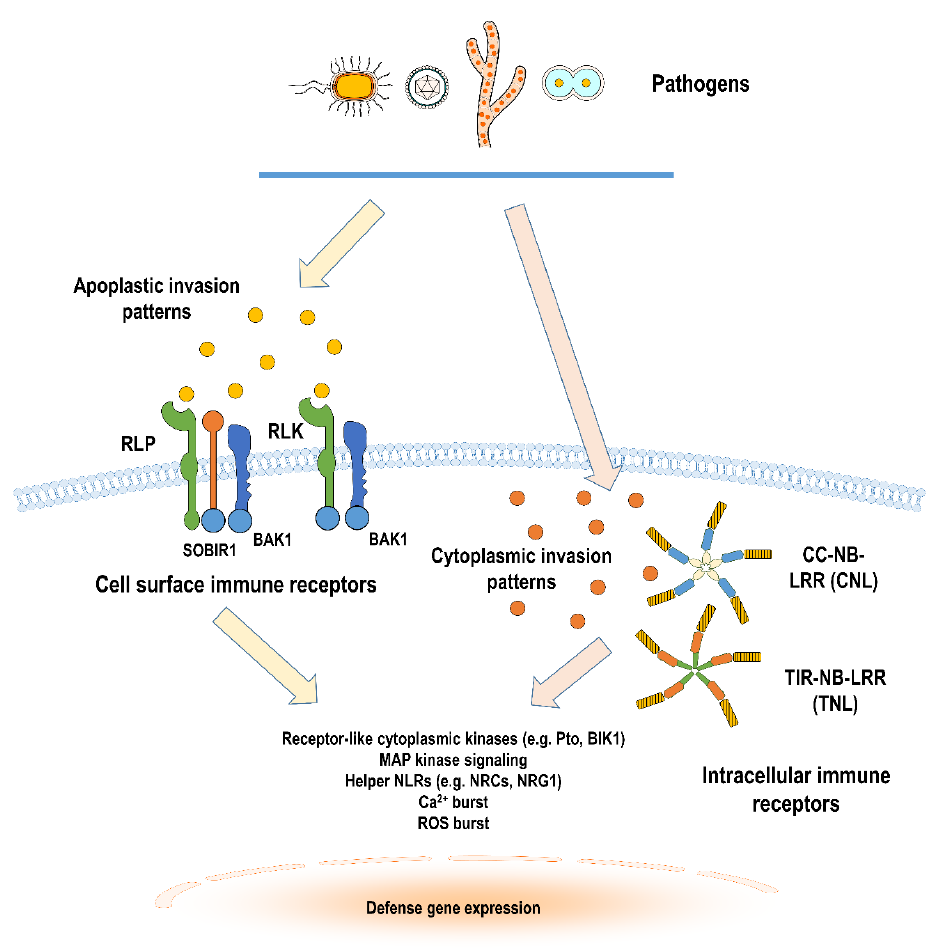
Figure 1. Model of cell surface and intracellular immune receptor-mediated defense signaling in Solanaceous plants. Invasion by pathogens are monitored by plant immune receptors located in the cell surface and cytoplasm. Apoplastic invasion patterns, such as conserved structural epitopes, are recognized by cell surface immune receptors—RLKs (receptor-like kinases), RLPs (receptor-like protein) and their co-receptors. Cytoplasmic invasion patterns such as virulence-promoting e ff ectors are also monitored by NB-LRR (nucleotide-binding-leucine-rich repeat) receptors or NLRs, which could either have coiled coil (CC) or Toll / interleukin-1 receptor (TIR) domains in their N-terminal regions. Downstream of both these types of immune receptors, there are diverse molecular and cellular changes involved in turning on defense signaling. These signaling changes include interaction with various families of receptor kinases localized in the cytoplasm (like Pto and BIK1), phosphorylation cascades of MAP kinases, activation of convergent helper NLR proteins, and production of secondary messengers (like Ca 2 + ) or reactive oxygen species (ROS). These ultimately lead to the di ff erential regulation of various transcription factors to carefully tune gene expression according to the appropriate plant host defense output. (Generated in part using Motifolio Scientific Illustration Toolkits)